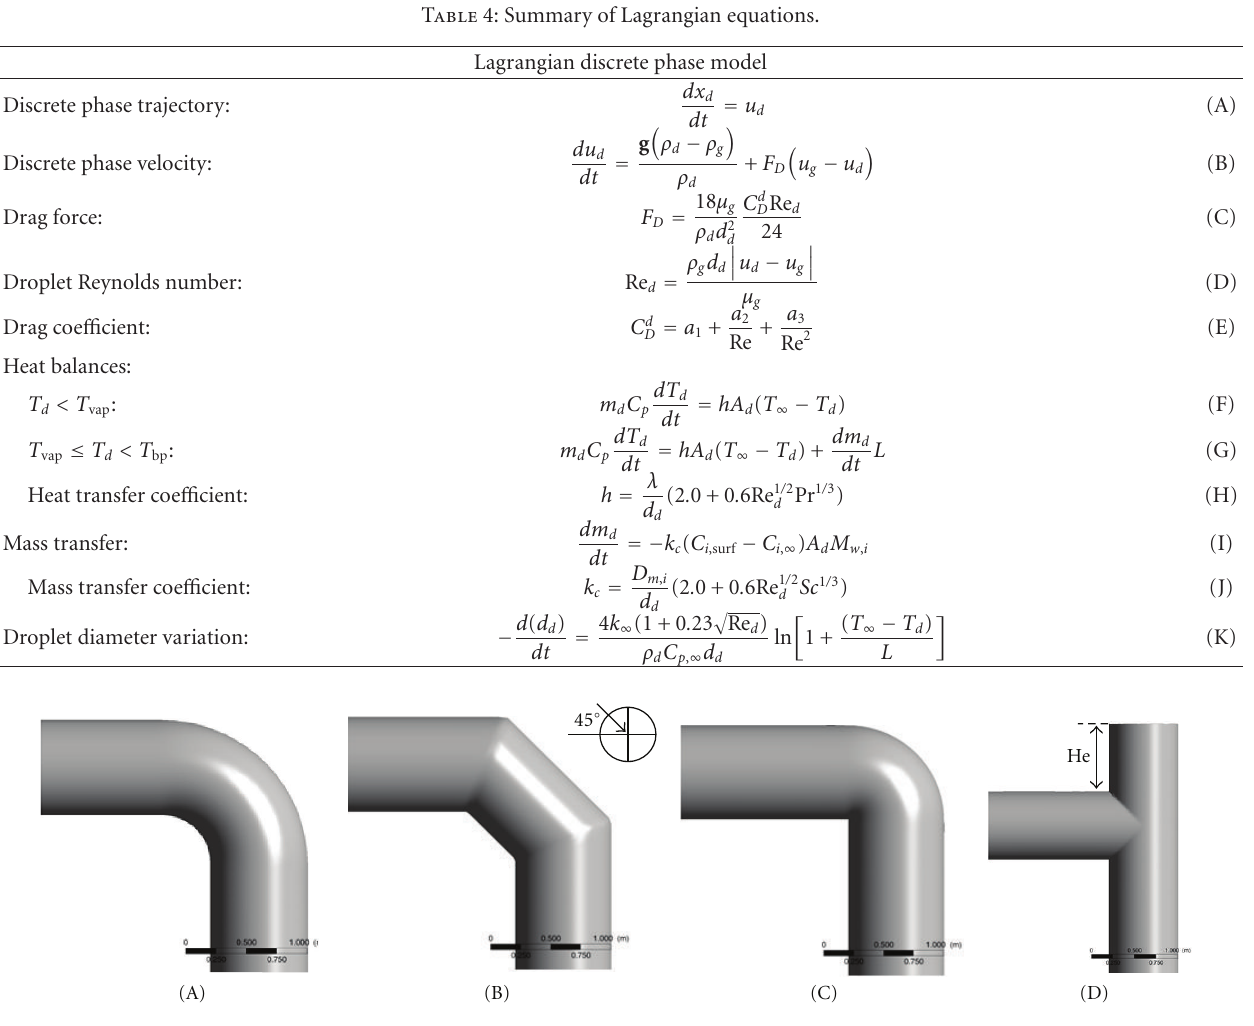
Figure 3: Exit configurations used in the